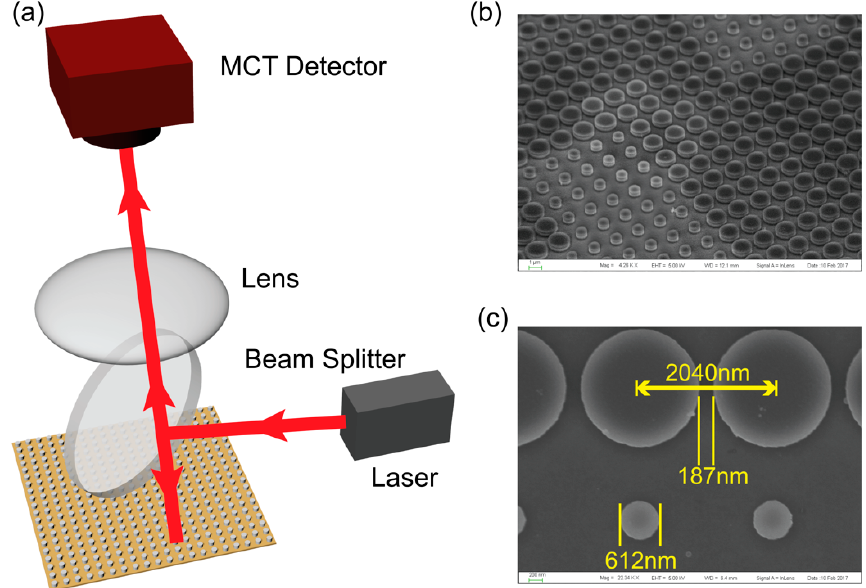
Figure 3. ( a ) Sketch of the on-axis optical scanning experiment setup for demonstration of the hologram. ( b , c ) The SEM images of the fabricated hologram in oblique view and top